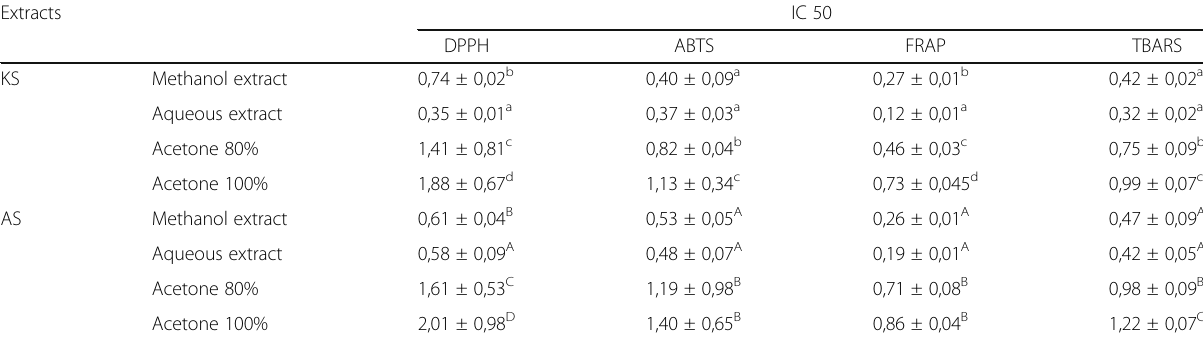
Table 1 Effect of solvents extraction on antioxidant activity (IC 50 . mg mL − 1 ) of both date palm seeds Extracts